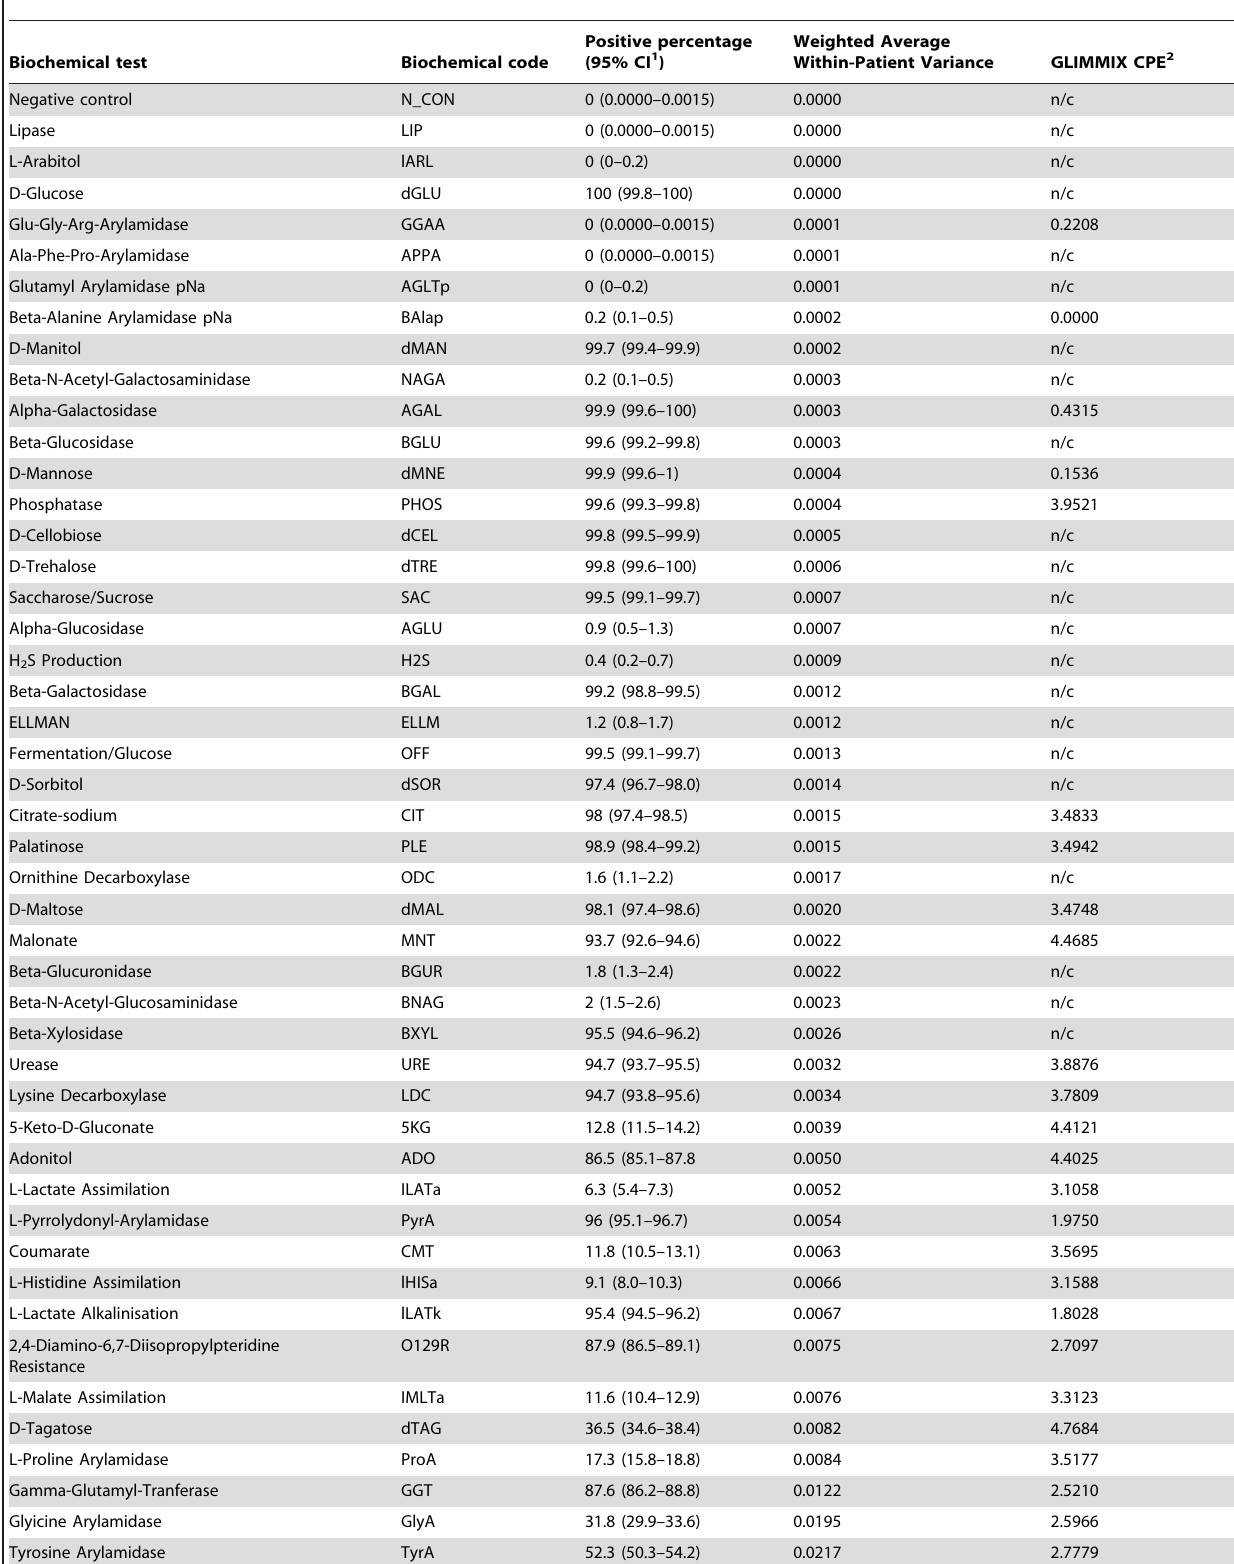
Table 1. Frequency of positive test results for patient first isolates of Klebsiella pneumoniae considering the 47 biochemical tests and negative control included in the Vitek 2 ID-GNB